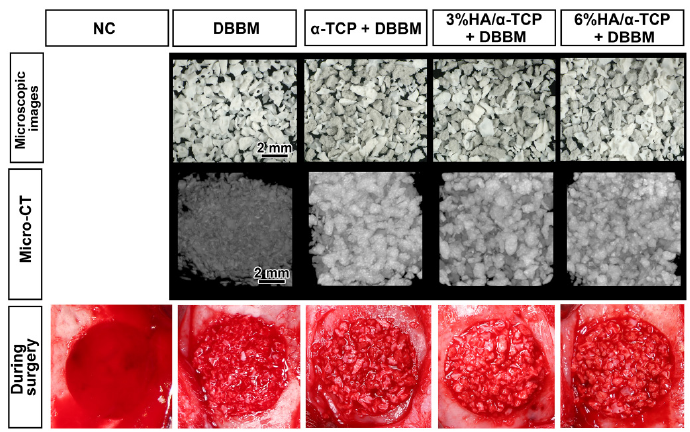
Figure 1. The images of the five tested groups: negative control (NC), DBBM alone, α -TCP + DBBM (1:1), 3%HA/97% α -TCP + DBBM (1:1), and 6%HA/94% α -TCP + DBBM (1:1). The microscopic